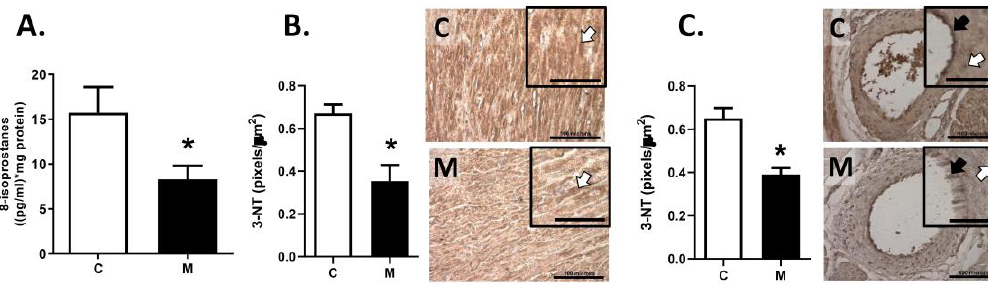
Figure 5. Oxidative stress in right ventricle. 8-isoprostanes ( A ) levels in right ventricle, 3-nitrotirosine (3-NT) immunostaining in RV free wall ( B ) and RV endocardial arteries ( C ) as oxidative markers in 29 days old lambs. Groups are control (C, white bars) and melatonin treated (M, black bars). Representative micrographs are shown for each analysis with bar = 100 µ m. Zoom box inside the micrographs with bar = 50 µ m; white and black arrows show immunopositivity in muscle and endothelial areas, respectively. Data expressed as mean ± S.E.M. Significant differences ( p ≤ 0.05): * vs. CN.